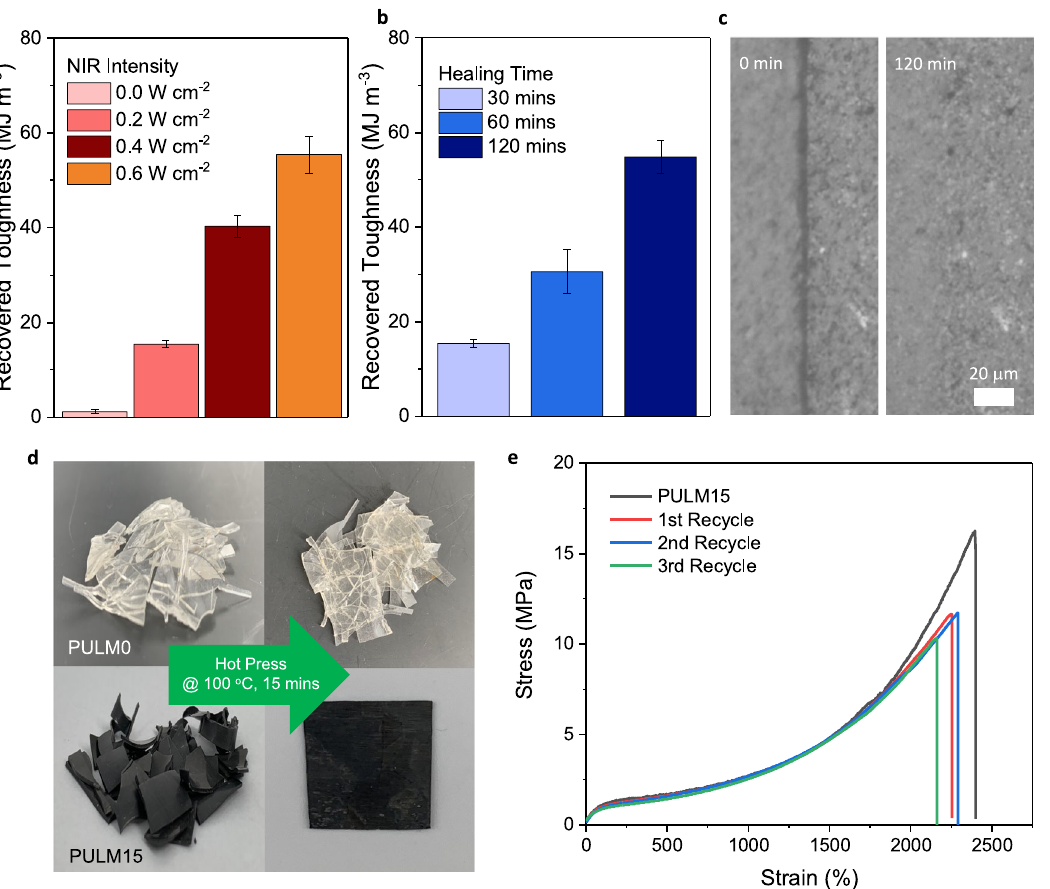
Fig. 3 | Self-healing and recyclability of PULM15 nanocomposite. a Recovered toughness of PULM15 at different NIR light intensity for 30min. b Recovered toughness of PULM15 at different healing times under NIR light of 0.2Wcm − 2 . c Optical microscope images of PULM15 damaged (left, 0min) and healed after 120min under NIR light of 0.2Wcm − 2 . d Digital images of PULM0 and PULM15